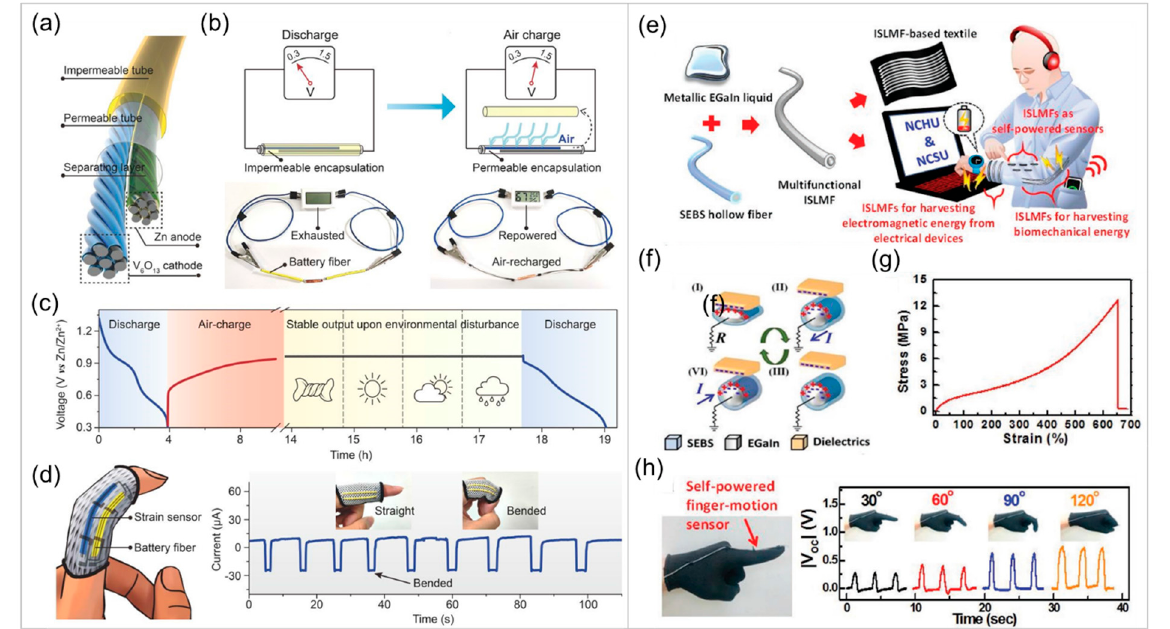
Figure 7. ( a ) Schematic of the double-layer-encapsulated Zn-ion battery fiber. ( b ) A thermometer powered by two air-rechargeable VCF/Zn battery fibers connected in series, shown in exhausted (left) and air-recharged (right) states, respectively. ( c ) The air-rechargeable VCF/Zn battery fiber presents stable voltage output under various environmental disturbances. ( d ) Left: schematic illustration of a strain sensor fiber powered by VCF/Zn battery fibers integrated in a flexible fingertip. Right: current-time curve of the strain sensor fiber upon the increasing bending cycle. ( a – d ) Reproduced with permission Ref. [69]. Copyright 2021, Royal Society of Chemistry. ( e ) Schematics of the fabrication process of the fiber TENG and its uses in collecting ambient energy and self-powered sensing. ( f ) Schematic illustration of the working mechanism for collecting energy from human motion. ( g ) Stress–strain curve of the fiber TENG. ( h ) Left: photograph of the fiber TENG as a self-powered finger-motion sensor. Right: real-time outputs when a finger is bent at different angles. ( e – h ) Reproduced with permission Ref. [73]. Copyright 2021,